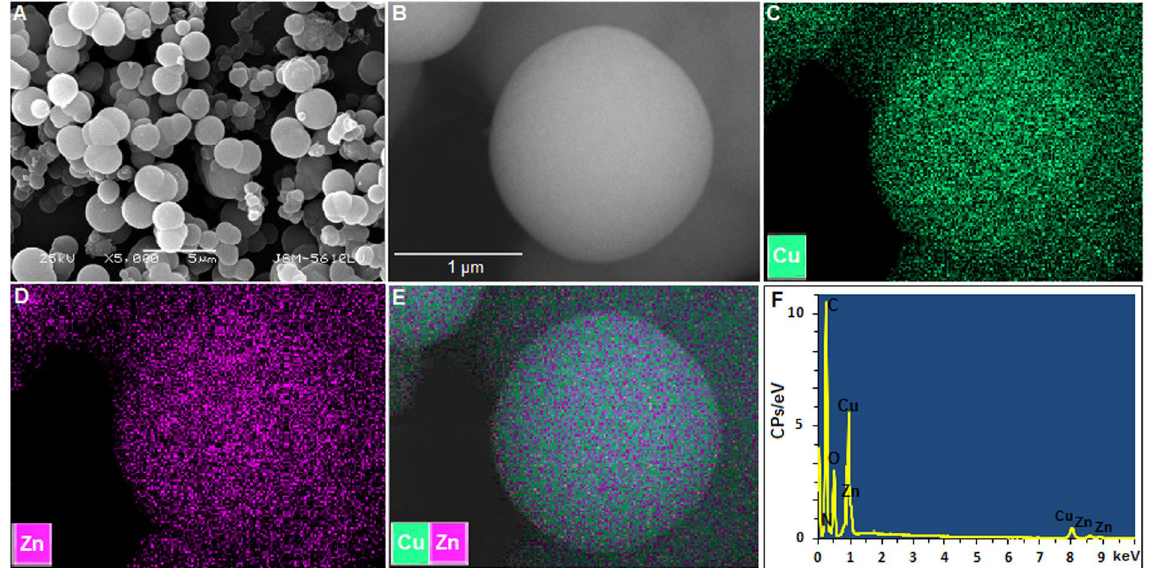
Figure 2. Field emission scanning electron microscopic (FE-SEM) images ( A and B ), energy-dispersive spectroscopic (EDS) mapping analysis for copper ( C ), zinc ( D ), and their overlay mapping ( E ), and EDS compositional analysis of the CuMOP-N1(Zn) obtained from overall elemental mapping analysis ( F